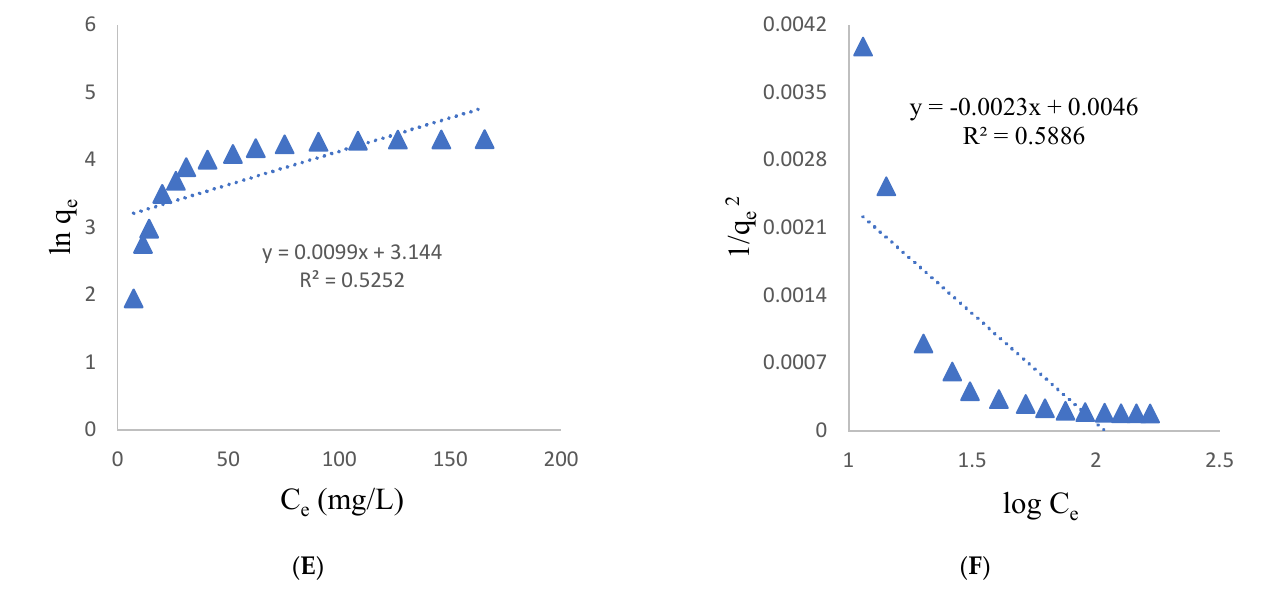
Figure 2. Isotherm applied: ( A ) Impact of initial Fe(II) concentration ( B ) Langmuir isotherm plot ( C ) Freundlich plot ( D ) Temkin isotherm plot ( E ) Jovanovic isotherm plot ( F ) Harkins jura isotherm plot.